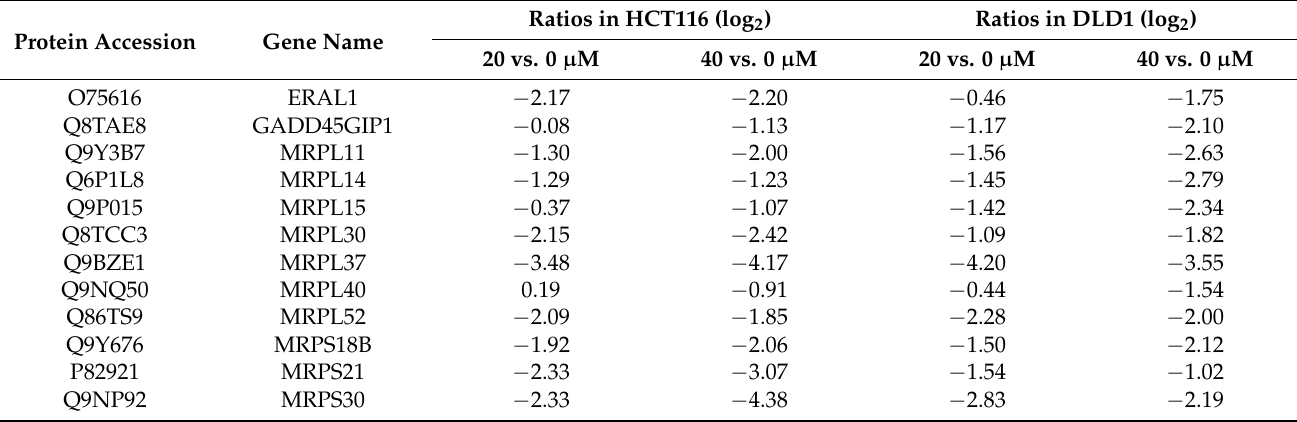
Table 1. Expression changes of top 12 overlapping proteins in PPI degree scores were shown for berberine-treated HCT116 and DLD1 cells. Protein